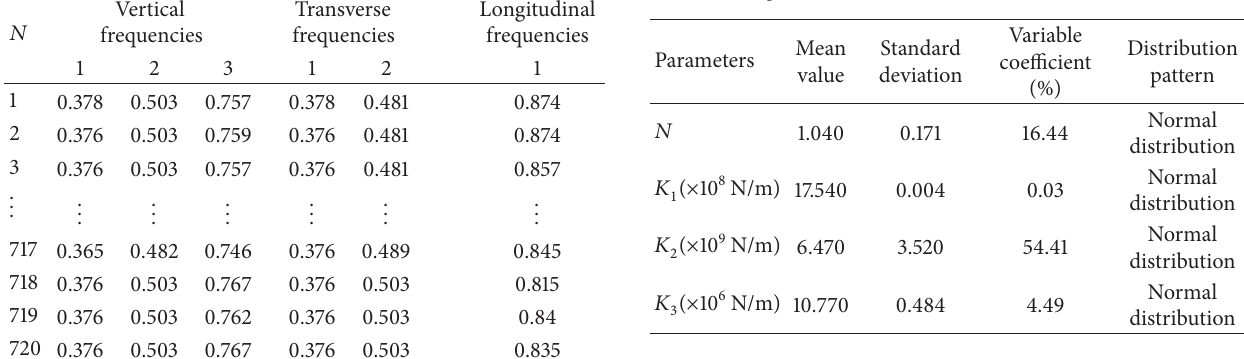
Table 12: Distribution characteristics of uncertainty parameters for Guanhe Bridge.